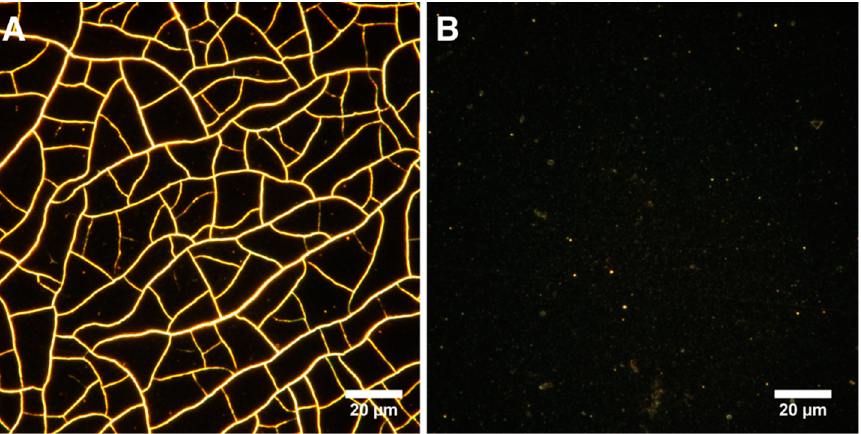
Figure 4. Visualization of surfaces with dark-field microscopy: ( А ) MNPs 3 mg/mL and ( B ) MNPs@DNA 3 mg/mL.